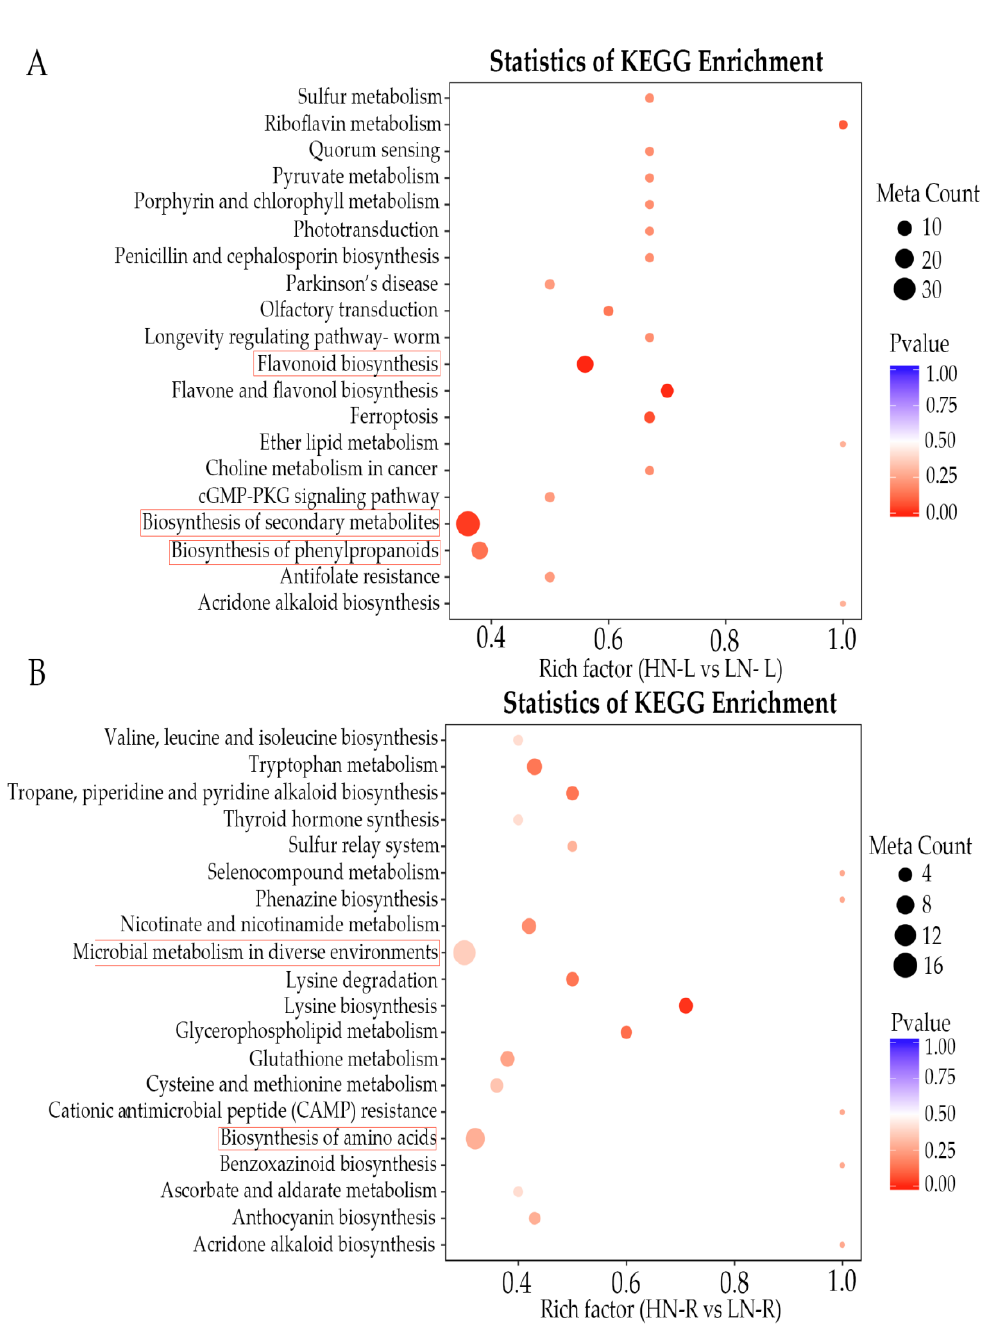
Figure 5. Enrichment analysis of the detected metabolites. Significantly enriched KEGG pathways ( p < 0.05) from detected metabolites in HN-L vs. LN-L ( A ) and HN-R vs. LN-R ( B ). The x-axis shows the fold enrichment. The y-axis shows the metabolic pathway terms. The size of the plotted circle indicates the number of metabolites. The red solid box represents the key enrichment pathway.